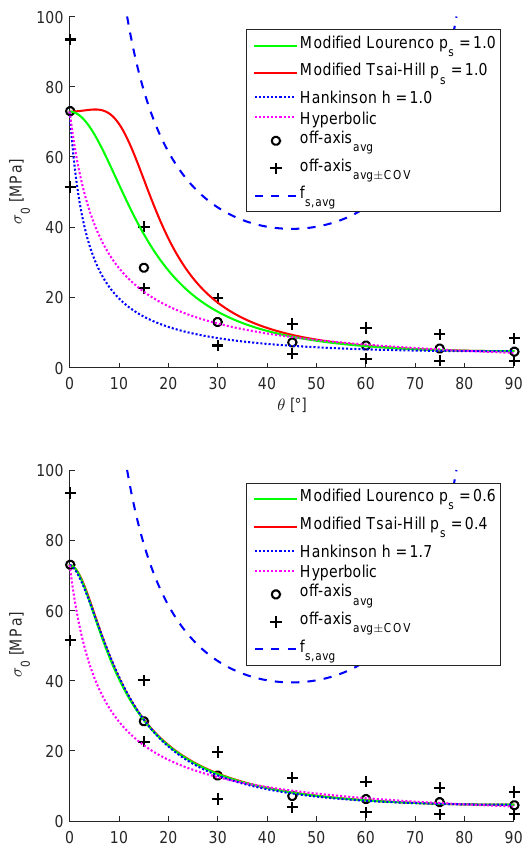
Figure 5. The experimental data of Cupiúba [20] with uncalibrated (top) and calibrated (bottom) failure